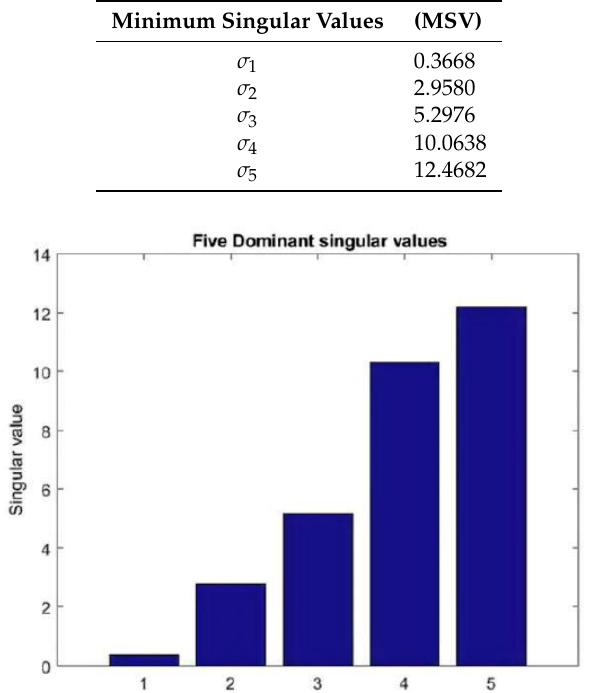
Table 3. First 5 MSVs for all period of wind curtailment: Case I.